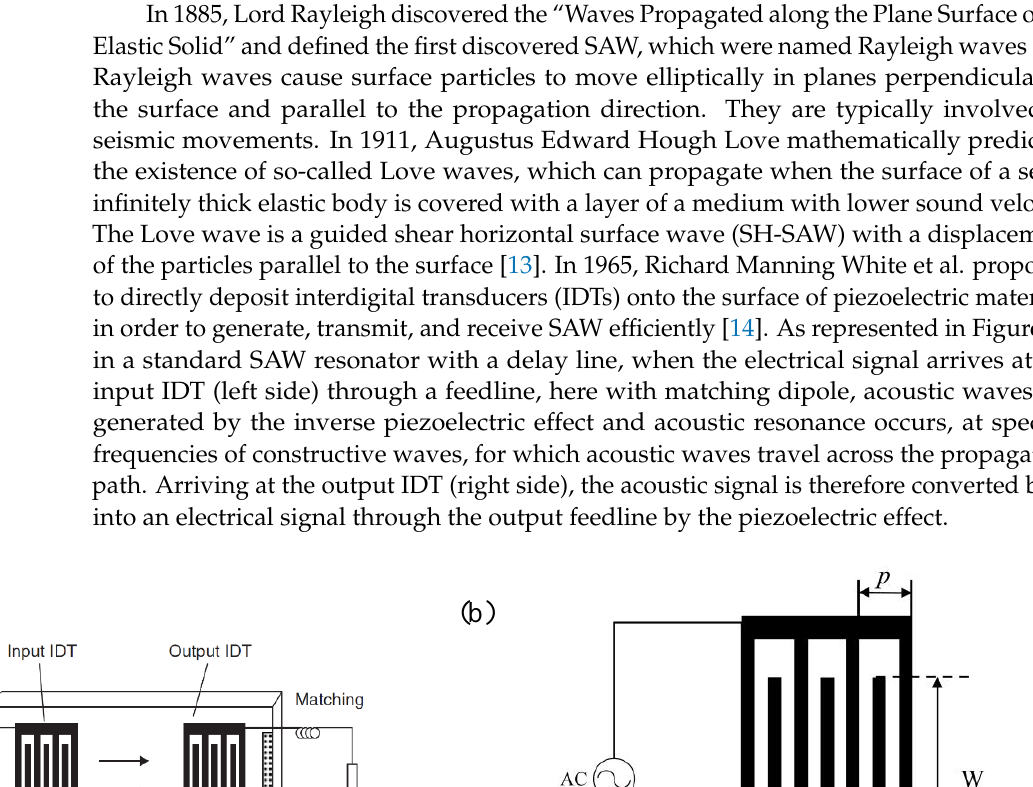
Figure 1. Profiles of (a) thickness-extensional mode and (b) thickness-shear mode of a BAW device; (c) SAW.